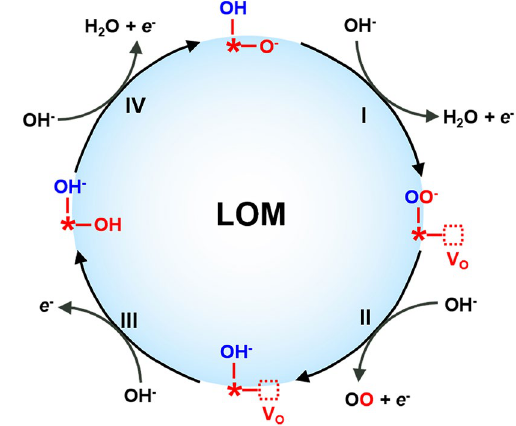
Fig. 12 The OER catalytic cycle based on LOM. Here, * represents the surface-active TM cation, and the red dotted square represents the oxygen vacancy V O . The four elementary steps I, II, III, IV cor- respond to Eqs.